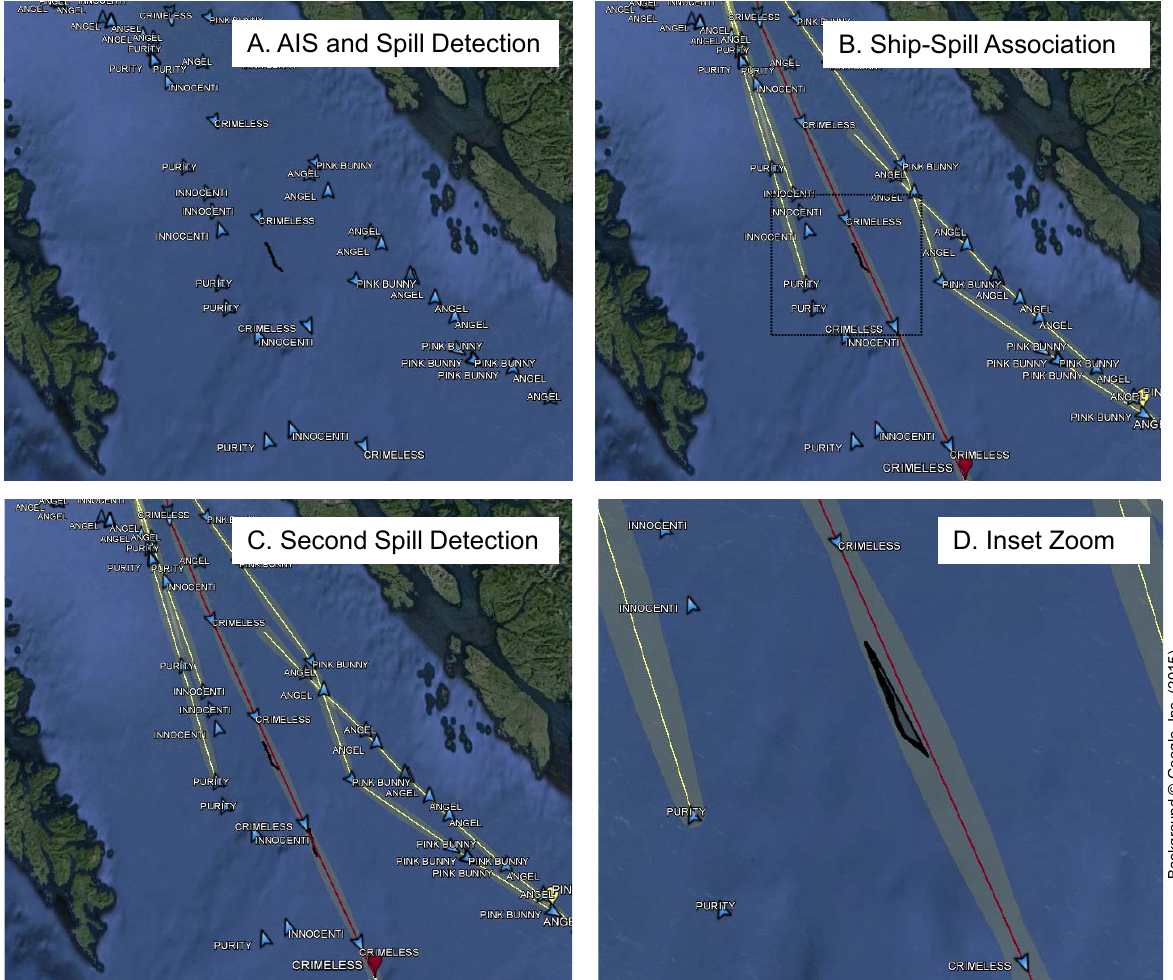
Figure 2. Ship-Spill Association Results for Test Case